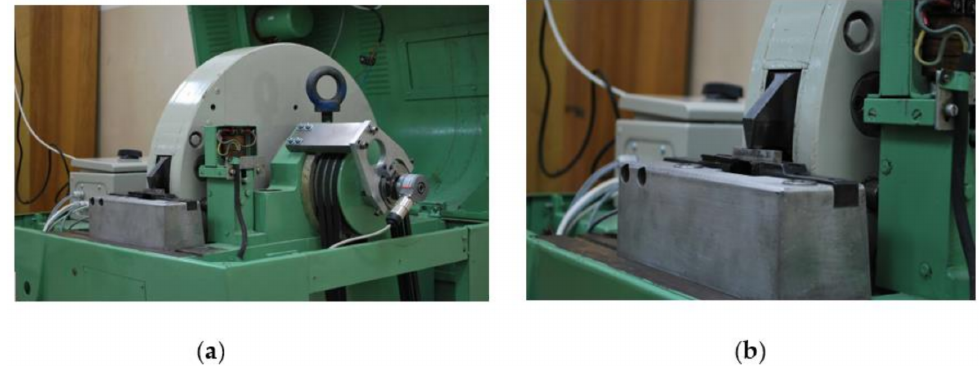
Figure 4. View of the rotary hammer in impact bending tests ( a ); the sample resting on the anvils and the claw in the working space ( b ).